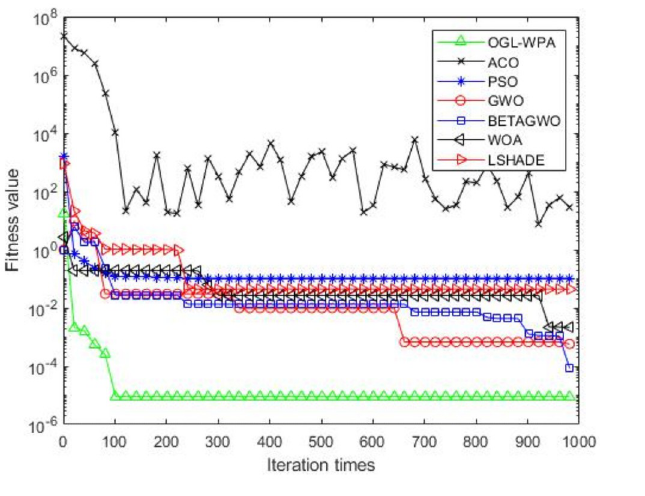
Fig 6. F5 iteration curve.